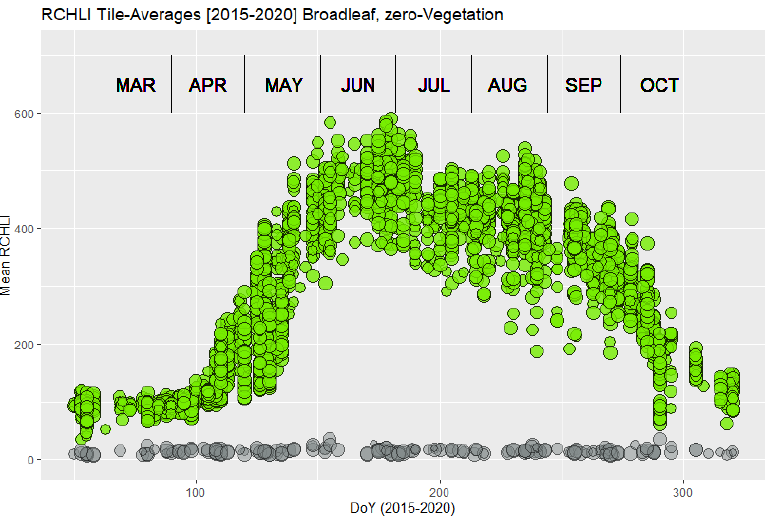
Figure 9. Average annual course of chlorophyll pigment concentration and biomass (RCHLI) of deciduous forest stands derived from S-2 imagery over the years 2015–2020. Each symbol corresponds to the RCHLI average for deciduous forest within each of the 38 S-2 tiles (30 × 30 km 2 ) with less than 25% cloud coverage of the tile area. For comparison, RCHLI values from unvegetated reference areas (airport aprons) are shown in grey.